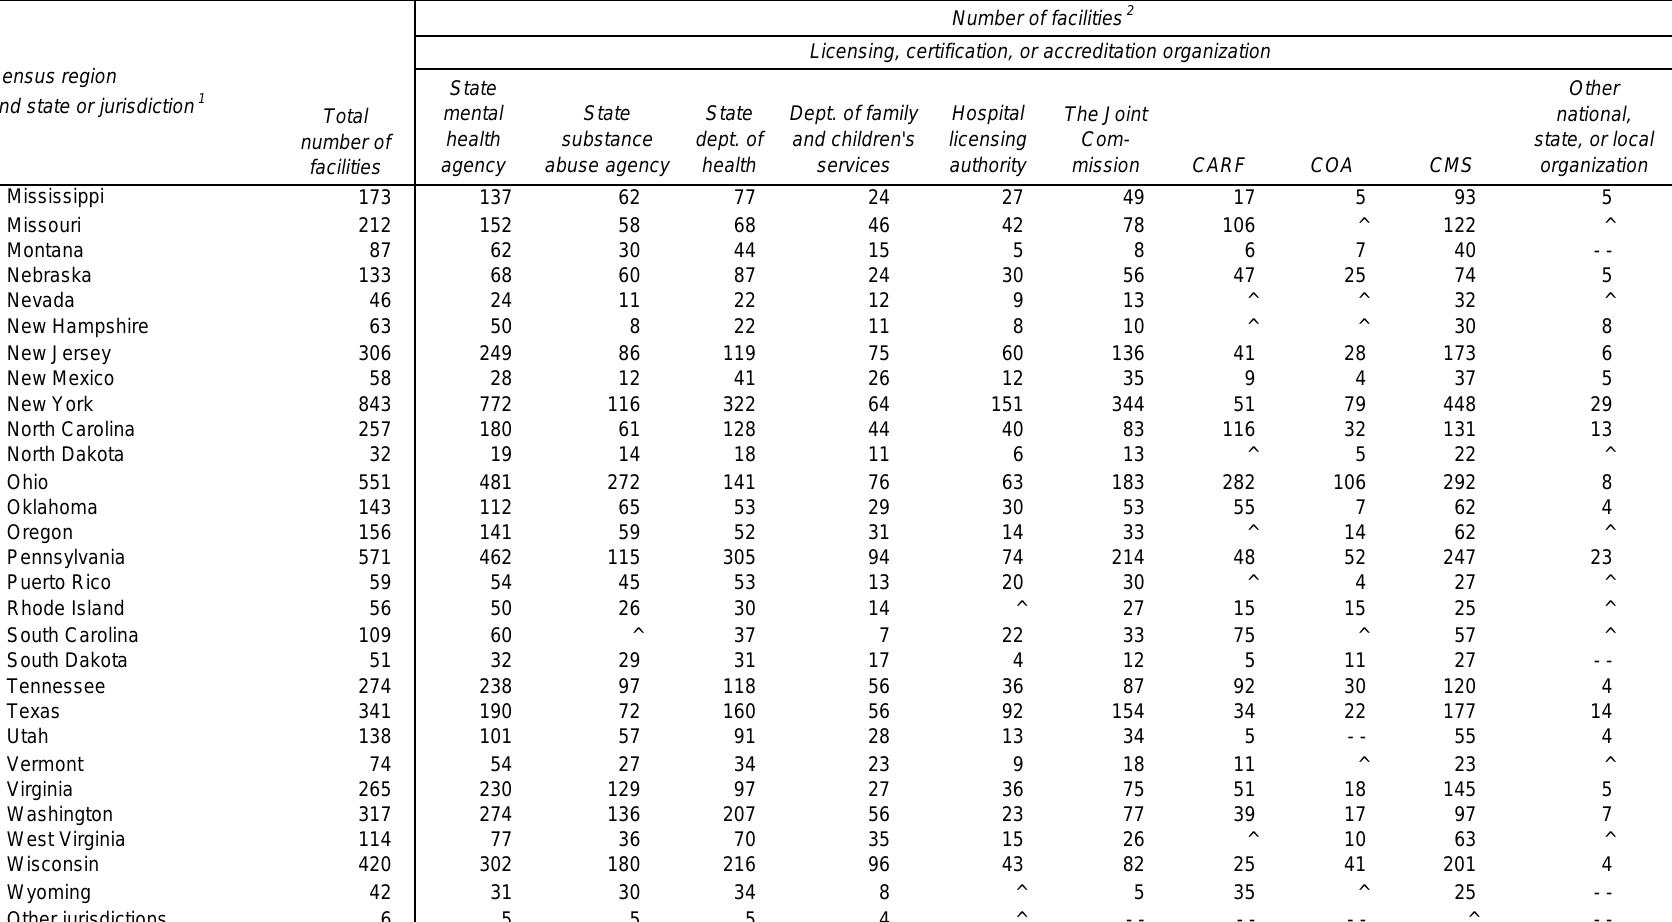
Table 3.14a. Mental health treatment facility licensing, certification, or accreditation, by Census region and state or